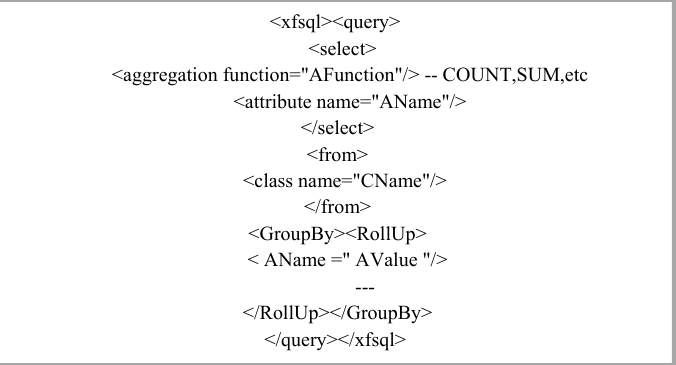
Fig. 6. Rollup syntax with XML tags